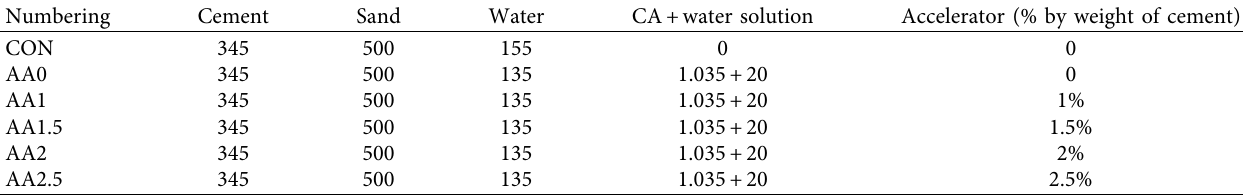
Table 2: Mix proportions of the mortar (g/kg).